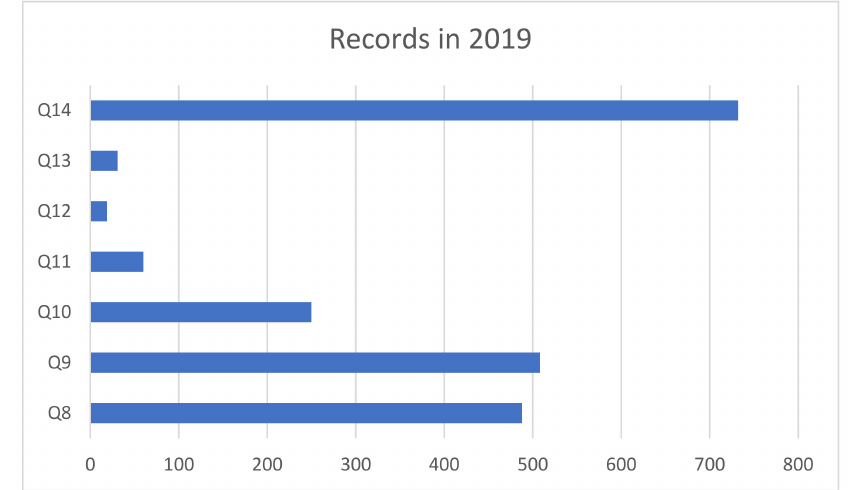
Figure 2. Survey responses to